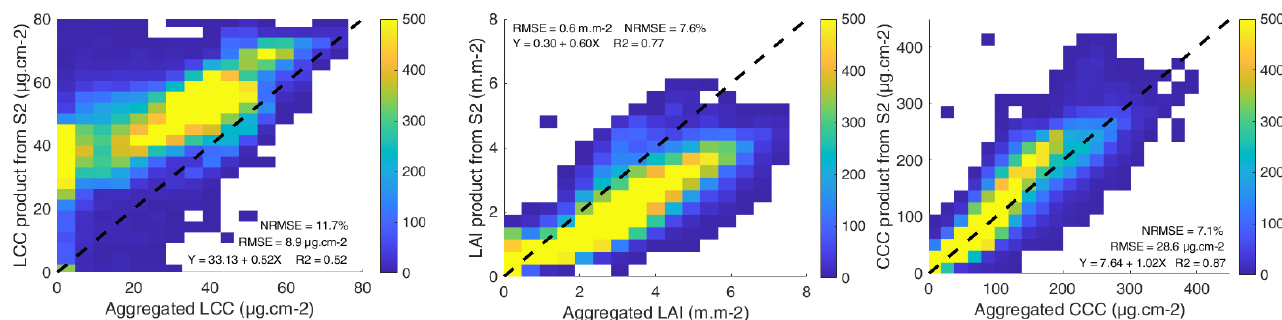
Figure 6. Comparison of the aggregated fine-scale estimations from Hyplant* with the corresponding 20 m resolution S2 products. Only LAI and CCC are products provided by the S2 ToolBox, whereas LCC was calculated by dividing CCC by